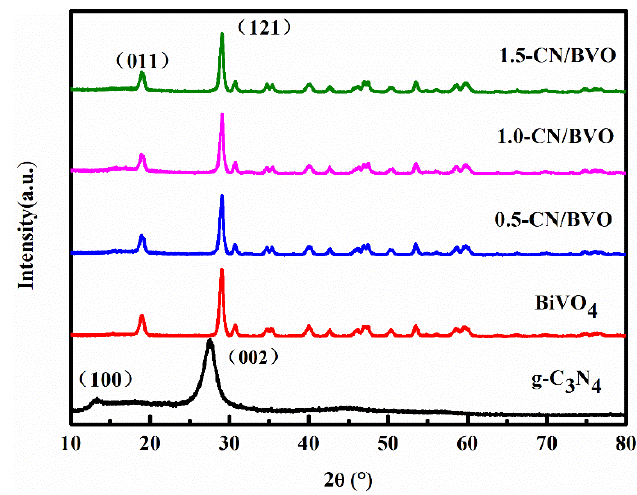
Figure 1. The XRD patterns of as-prepared samples.